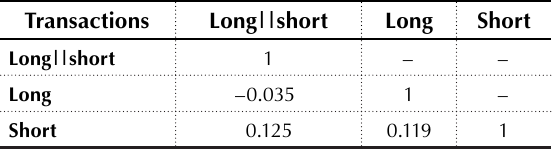
Table 6. Sums of profits during the 79 week period for Expert Advisors running with parameters optimized with a priori knowledge of the best backtesting periods